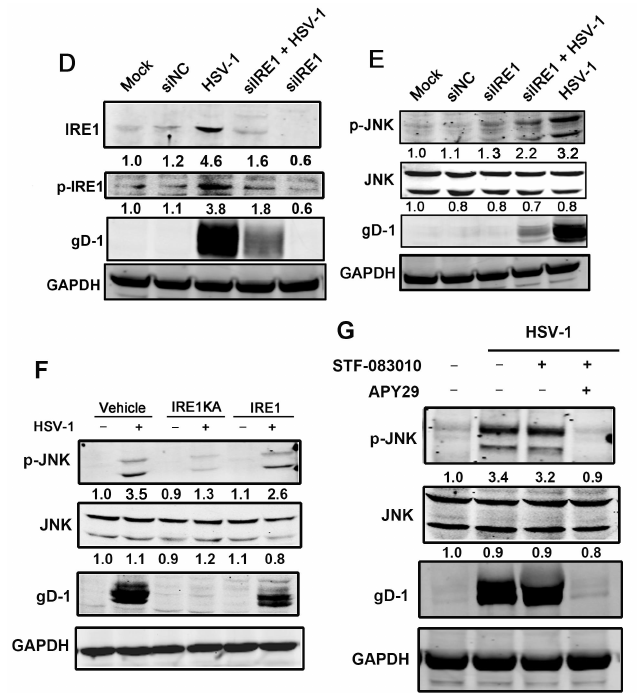
Figure 4. HSV-1 viral replication was regulated by kinase activity of IRE1 α via JNK signal pathway. ( A ) HSV-1 infection induced the activation of JNK pathway in HEC-1-A cells. HEC-1-A cells were infected with HSV-1 (moi = 1). Whole-cell lysates were prepared from infected cells at the post infection times indicated and subject to Western blot analysis using antibodies against phosphorylated JNK, JNK, and gD. The number under each band represents the relative density of the band in comparison to the corresponding control normalized to GAPDH; ( B ) SP600125 had an inhibitory effect on viral replication in HEC-1-A cells. HEC-1-A cells were pretreated with serial concentrations of SP600125 for 30 min and then infected with HSV-1 (HF) (moi = 1). The total and phosphorylated JNK, and gD protein were analyzed by Western blot at 24 h p.i. The number under each band represents the relative density of the band in comparison to the corresponding control normalized to GAPDH; ( C ) IRE1 α knock-down reduced HSV-1 viral gene replication in Hela cells. Hela cells were transfected with scramble siRNA as negative control (NC) or IRE1 α siRNA for 48 h and then infected with HSV-1 (moi = 1), total RNA was extracted at 24 h p.i., both viral gD RNA level and IRE1 α mRNA level were determined by real-time PCR and normalized to GAPDH. Data are means of three independent wells, and the bars represent the mean values ± SD, ** p < 0.01; ( D ) IRE1 α knock down reduced the kinase activity of IRE1 α and viral replication in Hela cells. Hela cells were treated according to material and methods Section 6, total cellular protein was harvested at 24 h p.i. and then phosphorylated IRE1 α level, total IRE1 α and gD expression were measured by Western blot using indicated antibodies; ( E ) IRE1 α knock-down attenuated JNK activation stimulated by HSV-1 in Hela cells. Hela cells were treated according to material and methods Section 6, total cellular protein was harvested at 24 h p.i. preparing for Western blot analysis against gD, total and phosphorylated JNK antibodies; ( F ) HSV-1 stimulated JNK activation was suppressed by inactivation of IRE1 α kinase activity in Hela cells. Hela cells were treated as describe in material and methods 7. Total cell lysates were prepared after 24 h p.i. for Western blot analysis using antibodies directed against gD, phosphorylated JNK and JNK; ( G ) IRE1 α kinase activity inhibitor repressed JNK activation induced by viral infection in HEC-1-A cells. HEC-1-A cells were pretreated or mock-pretreated with APY29 (3.125 µ M), only or both APY29 (3.125 µ M), and STF-083010 (60 µ M) for 30 min and then infected or mock-infected with HSV-1 (moi = 1). Total cell lysates were prepared and Western blot analysis was performed using specific antibodies at 24 h p.i. All experiments were performed three times. The representative results were